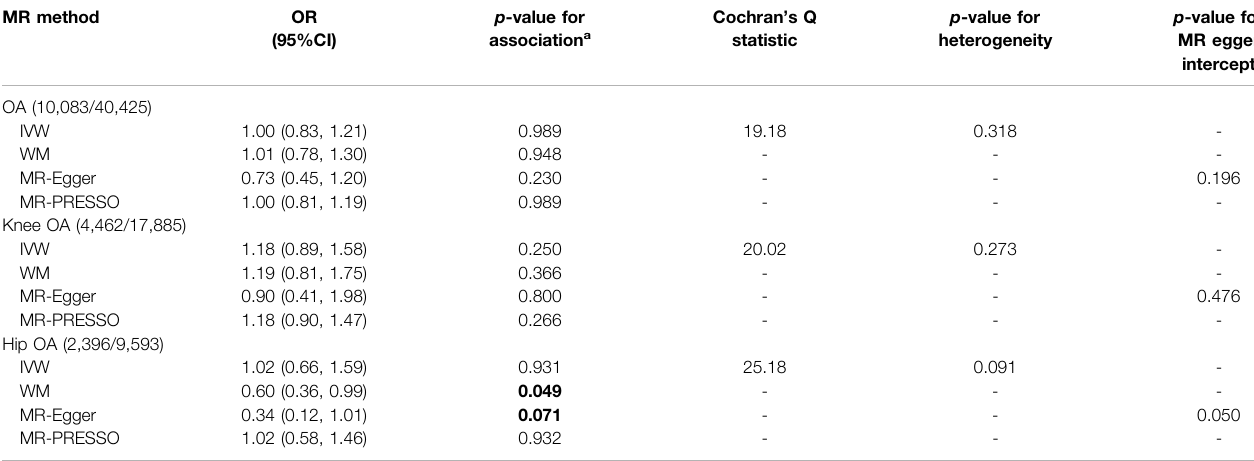
TABLE 2 | MR results of the association between TL and OA (18